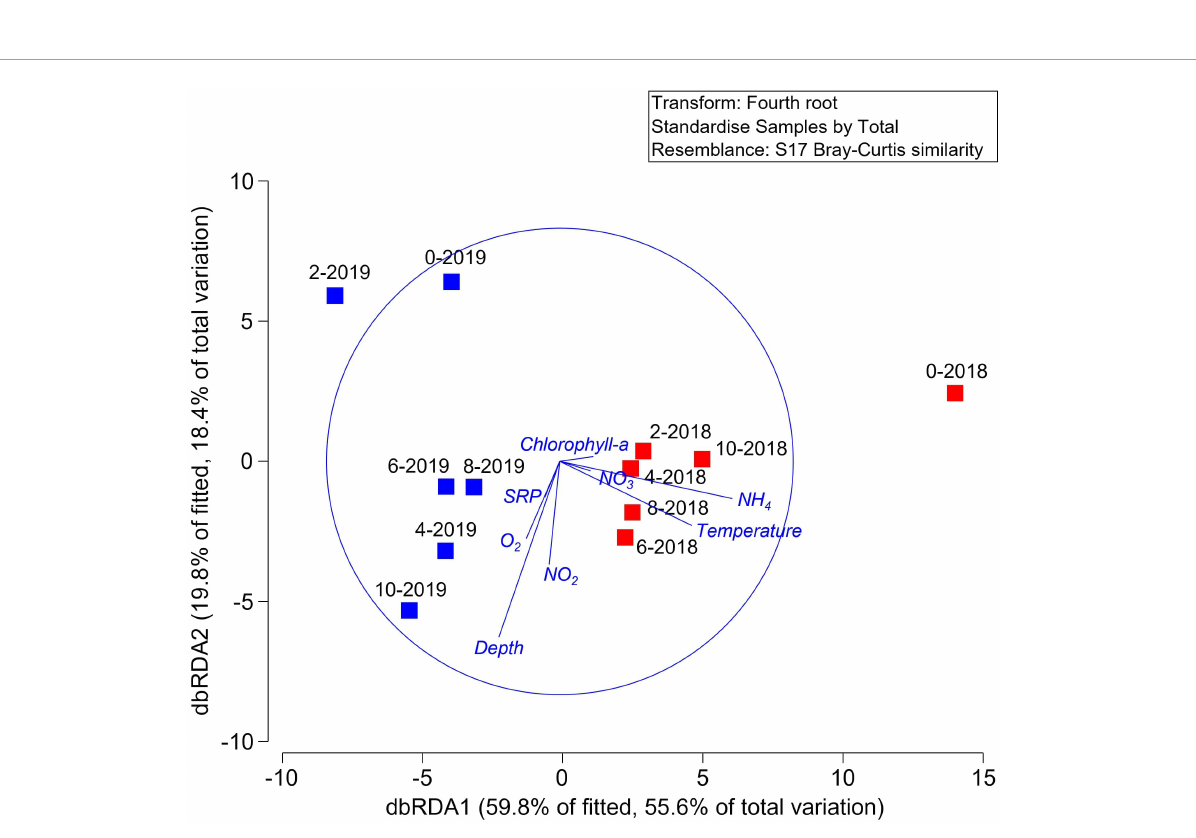
FIGURE6 Distance-based redundancy analysis (dbRDA) plot of the DistLM based on geochemical parameters fitted to the variation in functional abundance prediction using PICRUSt2. Vectors indicate direction of the parameter effect in the ordination